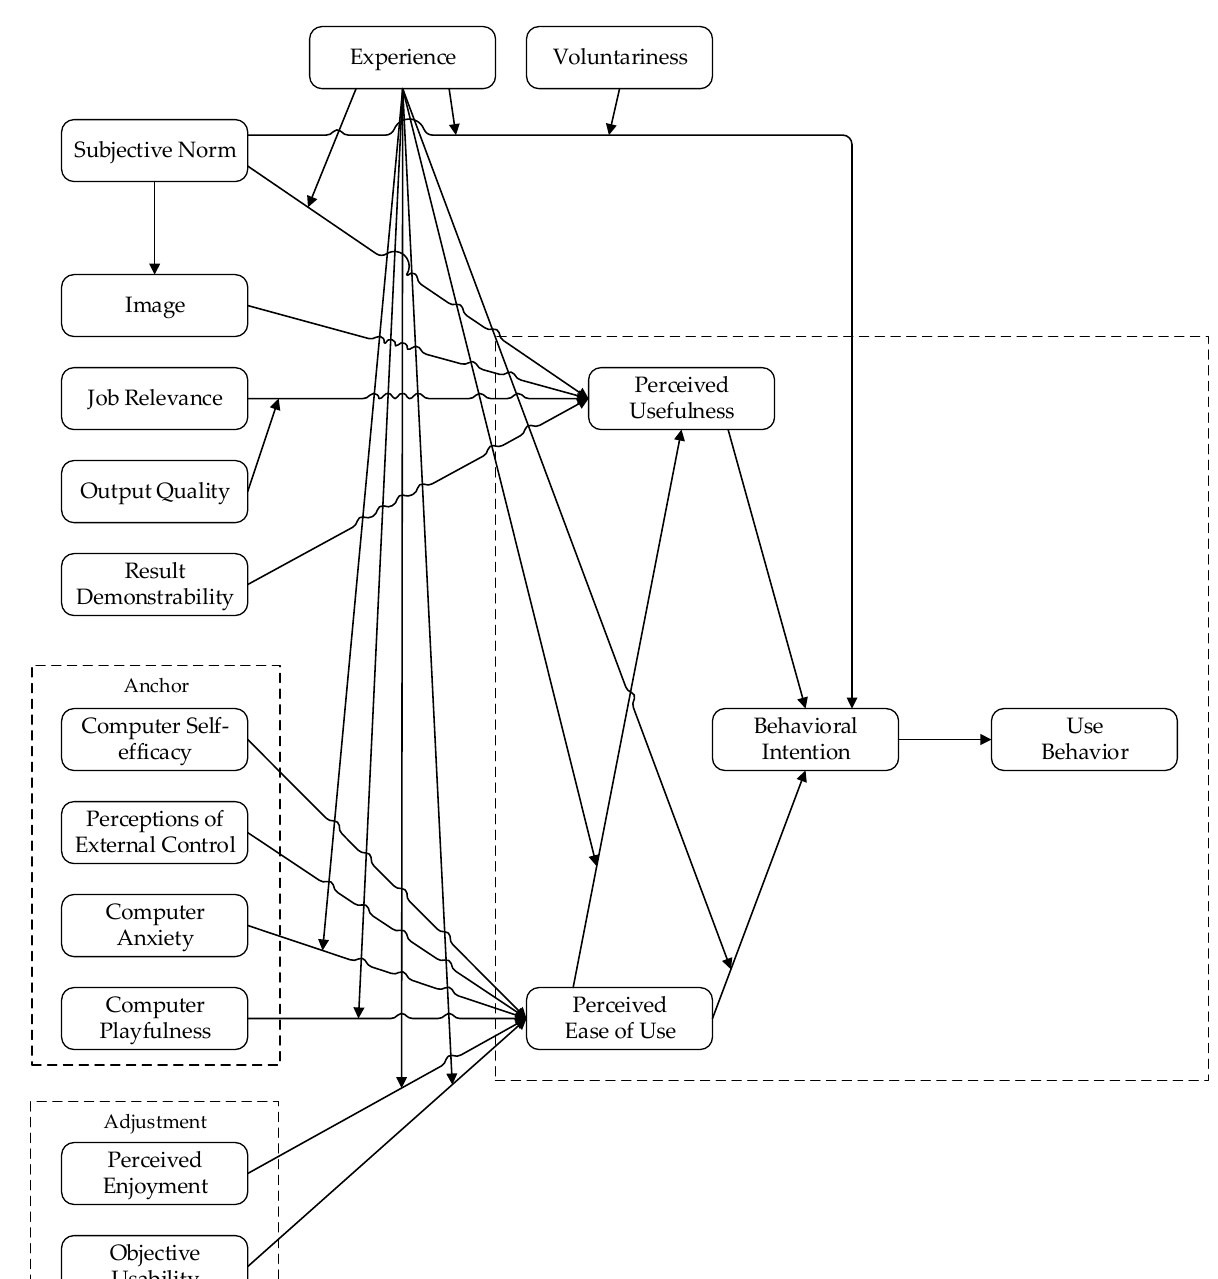
Figure 2. Technology Acceptance Model (version 3). Adapted from Venkatesh and Bala [33].